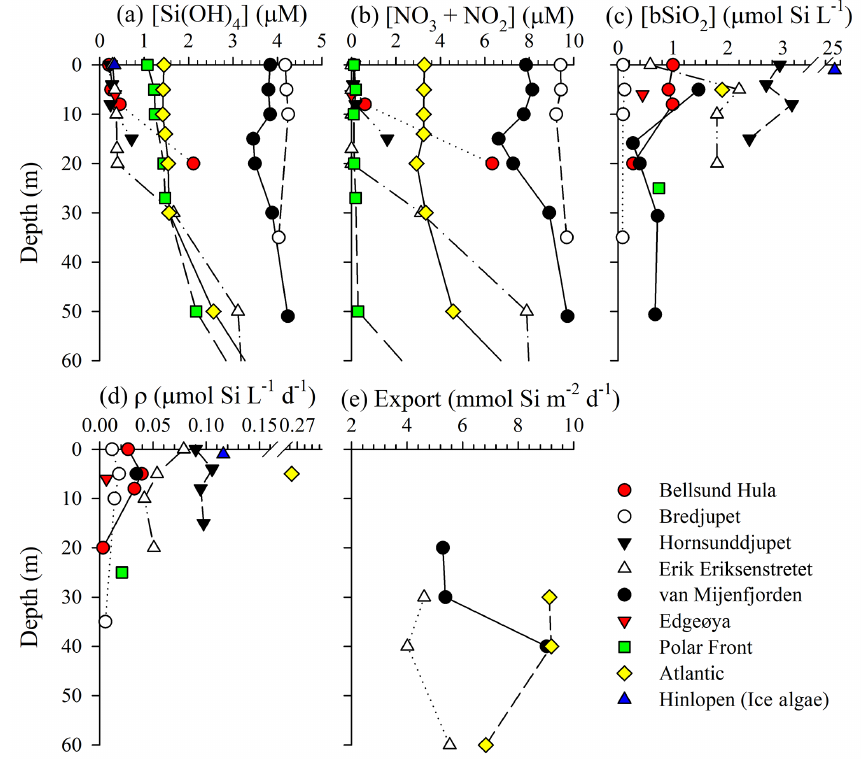
Figure 2. Vertical profiles for (a) dissolved silicic acid, (b) nitrate + nitrite, (c) biogenic silica standing stock, (d) biogenic silica production rate, and (e) biogenic silica export. Symbols are associated by station, and line connectors are used to denote profile data opposed to individual symbols noting samples at one